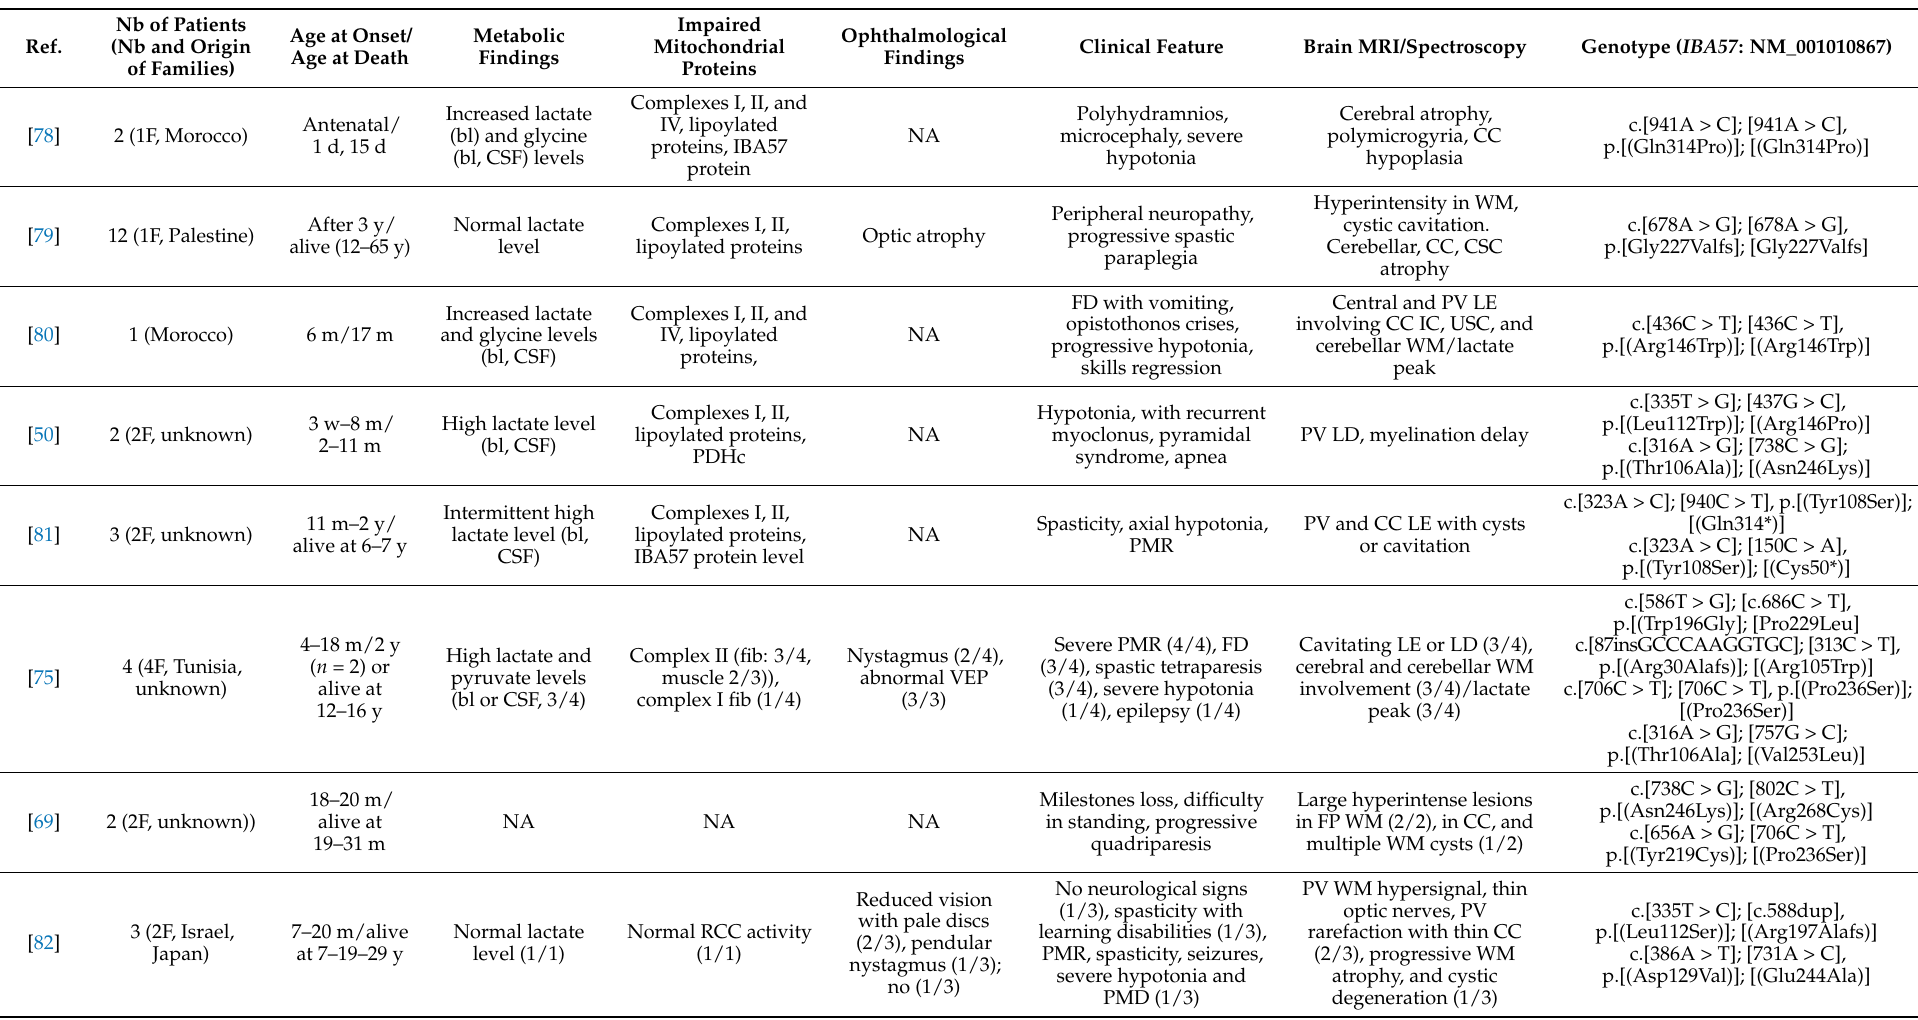
Table 3. Reported cases with MMDS type